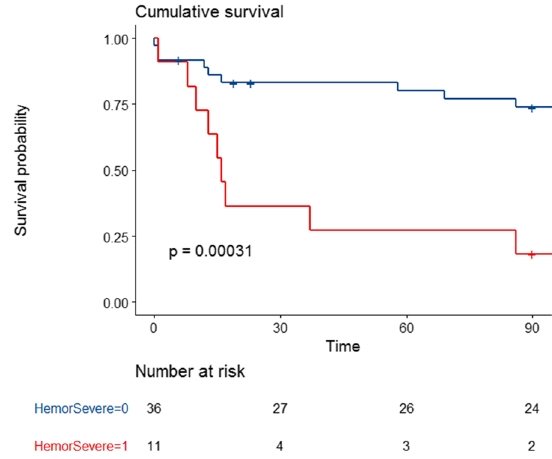
Fig. 1 Survival curve according to severe